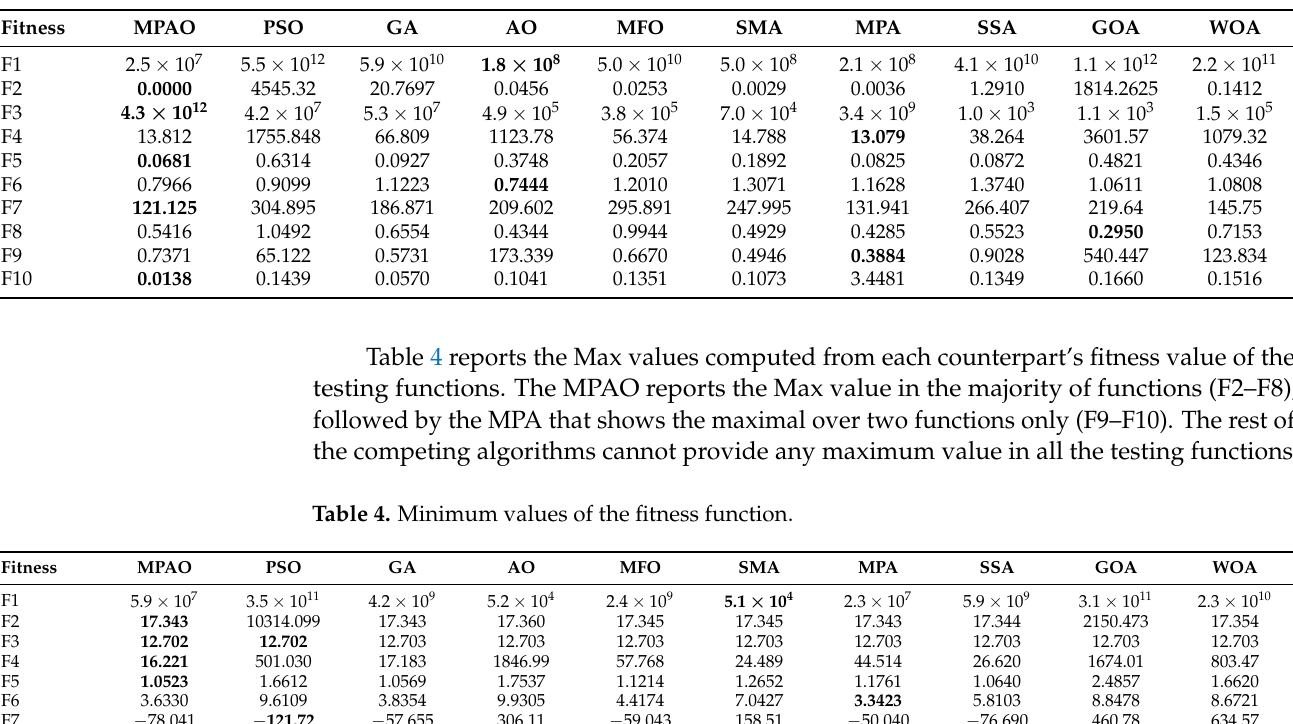
Table 3. Average of the standard deviation of the fitness function.